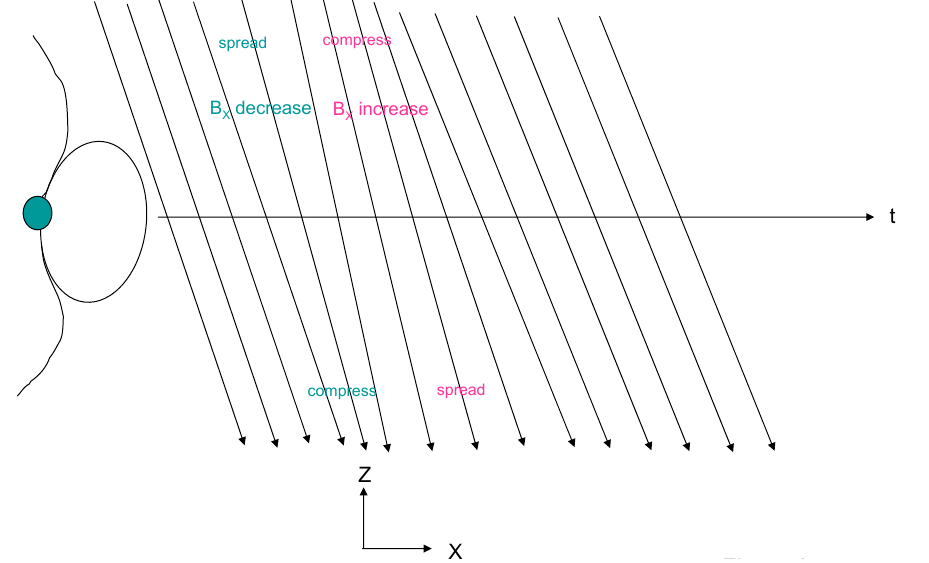
Fig. 3. Cartoon representation of magnetic field compression/spreading as B X changes the tilt of planes of constant IEF phase. Time is to the right along the axis, so that the earlier times reach the magnetosphere first as they flow with the solar wind in the X direction. The bow shock and draping of the magnetic field over the magnetopause, as well as variations in the Y direction, have been omitted for simplicity. Above and below the axis regions of compression (spreading) increase (decrease) the flux presented for merging at a particular location on the magnetopause. Table 1. ISM simulation input